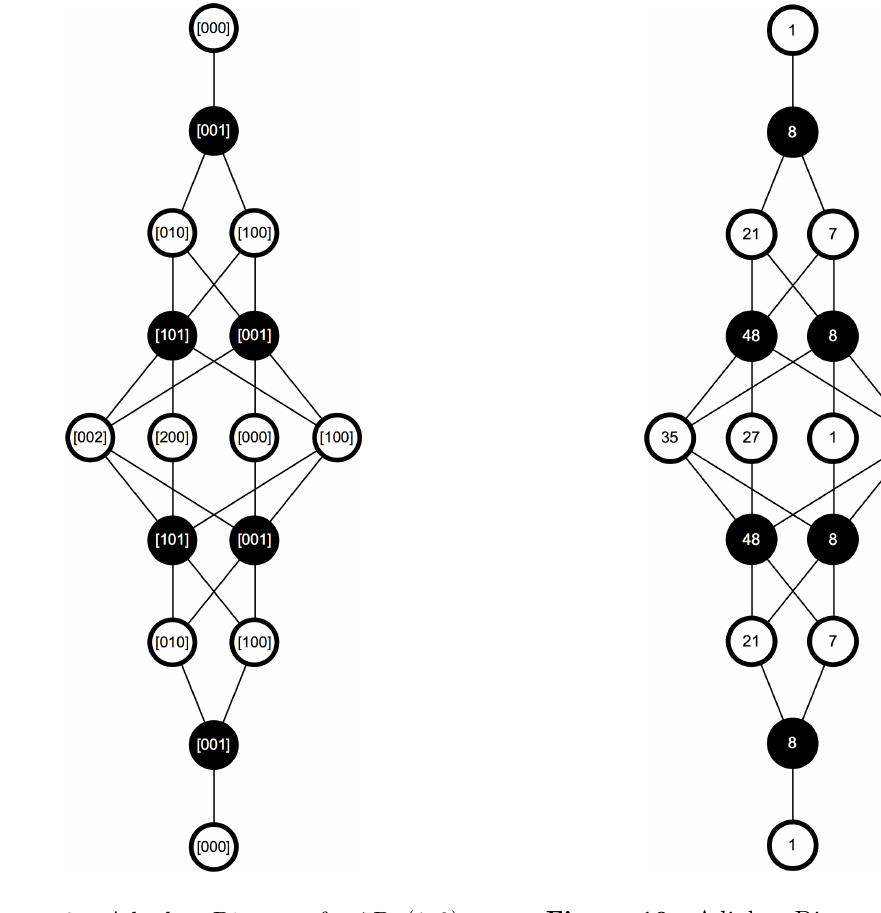
Figure 9 . Adynkra Diagram for 7D (1 , 0) Multiplet.